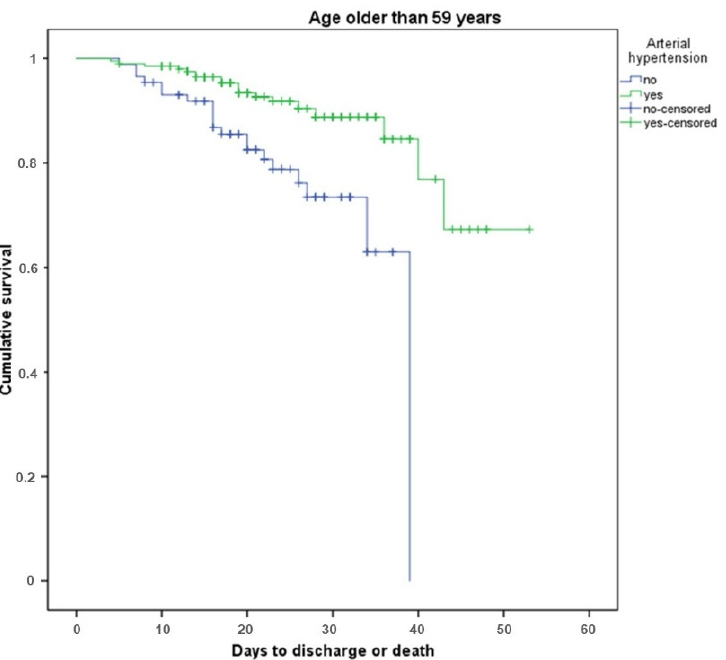
Figure 1. Kaplan–Meyer analysis of survival in age group older than 59 years in patients with and without arterial hypertension. Green line represents patients with arterial hypertension, blue line—patients without arterial hypertension.